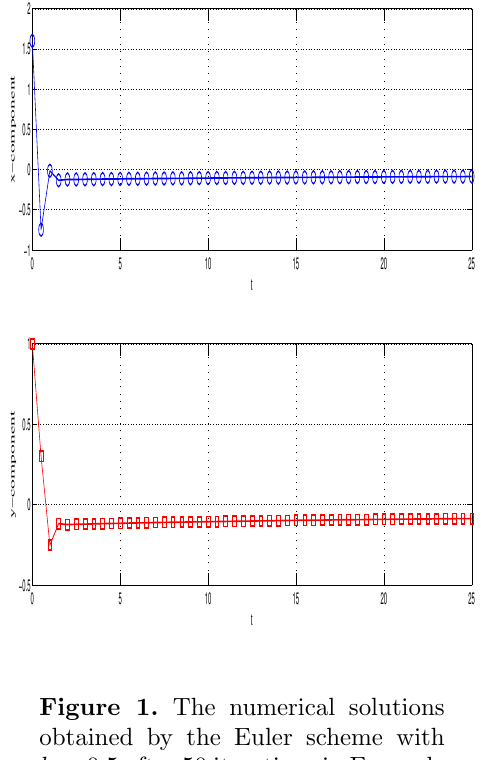
Figure 1. The numerical solutions obtained by the Euler scheme with h = 0 . 5 after 50 iterations in Example 3.